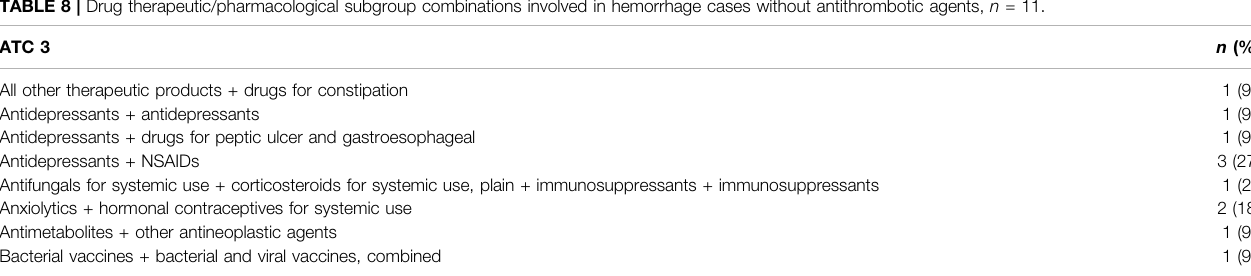
TABLE 8 | Drug therapeutic/pharmacological subgroup combinations involved in hemorrhage cases without antithrombotic agents, n (cid:1) 11. ATC